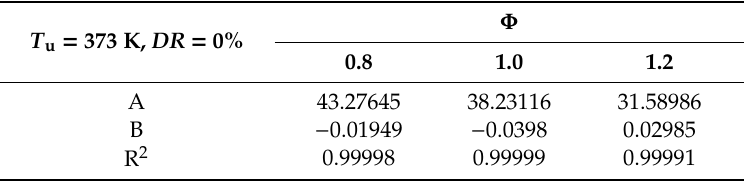
Table 4. Coefficients of the linear fit to the data of laminar burning velocity versus maximum concentration of H + OH under different initial pressures.